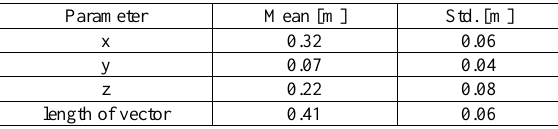
Table 5. Coordinate differences between camera and